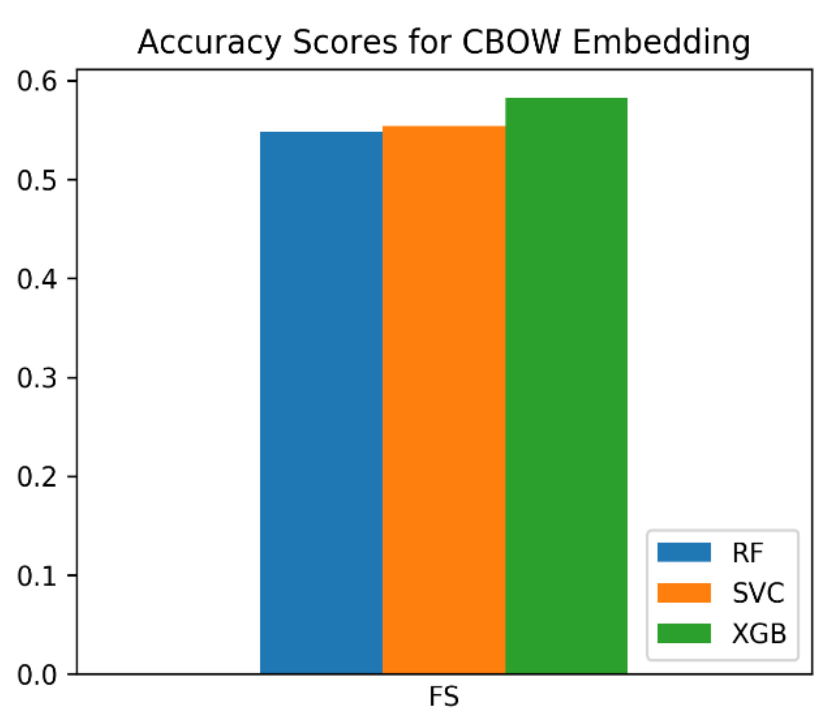
Figure 9. F 1 scores of self-trained Word2Vec embedding with the CBOW method.